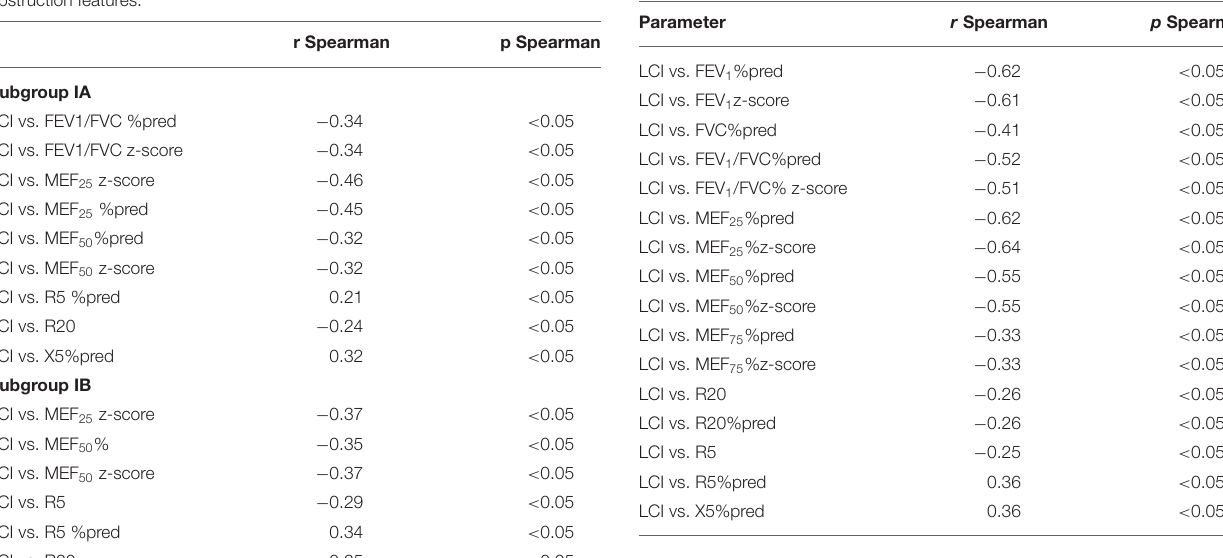
TABLE 5 | Correlation between LCI, spirometry, and IOS parameters in subgroup ID (LCI >